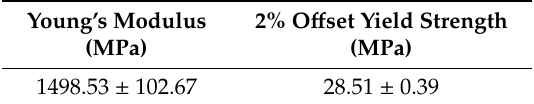
Table 3. Bulk compression properties of the FDM printed ABS-M30 ™ as per the orientation of the struts in Kagome